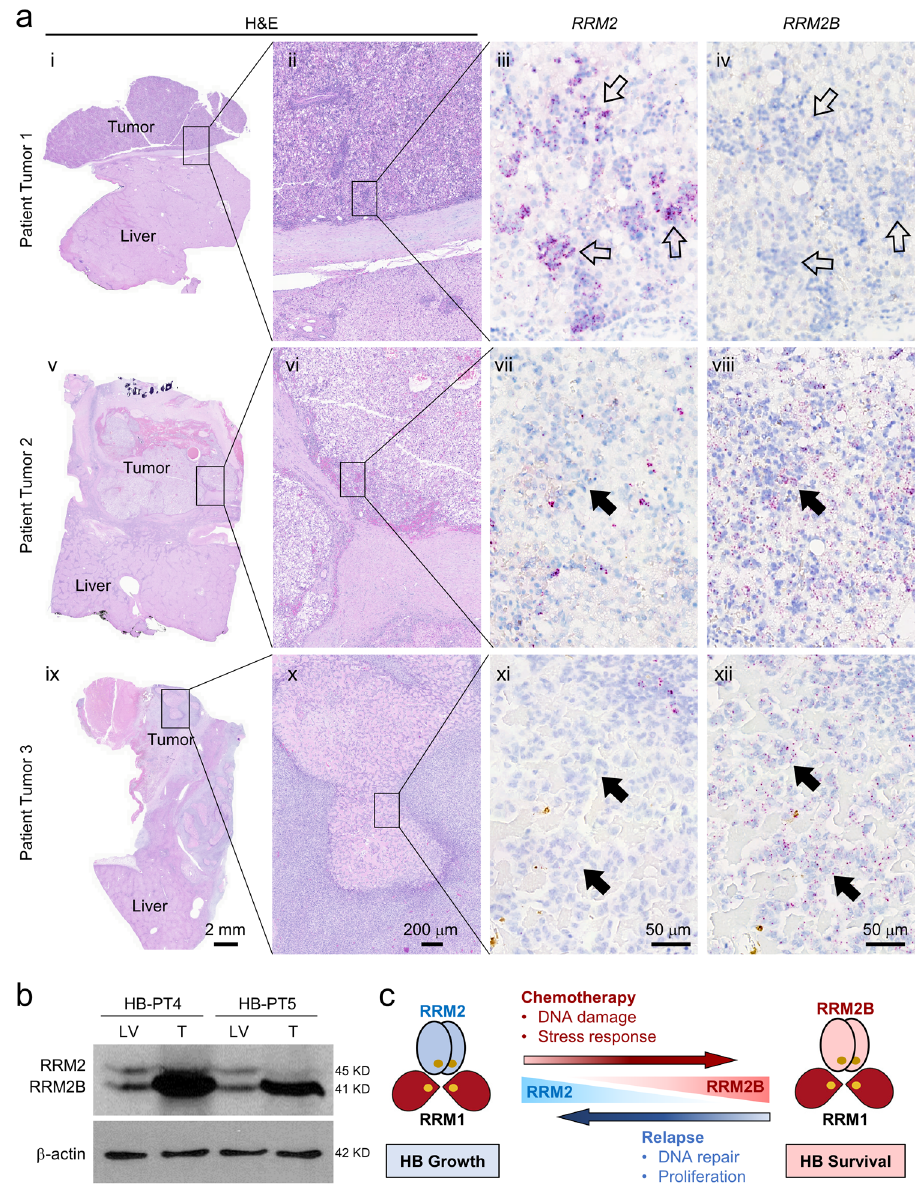
Fig. 8 RRM2B level is associated with drug response in HB patient tumors. a H&E staining, RNAscope staining for RRM2 and RRM2B on serial sections of three post-chemotherapy primary HB patient tumors. Open arrows in (iii, iv): RRM2 + / RRM2B − cells in viable tumor areas; arrows in (vii, viii) and (xi, xii): cells with evident RRM2B expression but not RRM2 expression in the tumor areas stressed by chemotherapy. Images on the same column share the same scale bar. b RRM2 and RRM2B immunoblotting of two primary HB patient tumors collected post-chemotherapy. c A working model of RRM2 and RRM2B subunit switching in HB growth, drug response, and